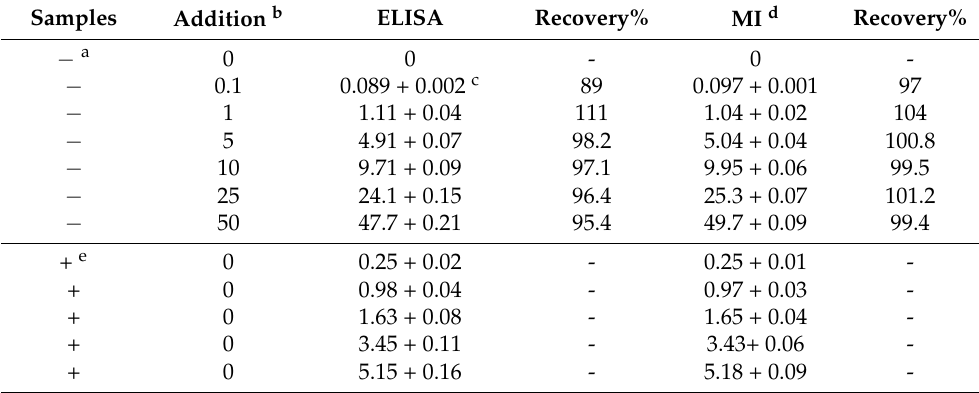
Table 2. Comparison of PSA data between the microfluidic electrochemical immunosensor and commercial ELISA kit for negative control (spiked) and positive control serum